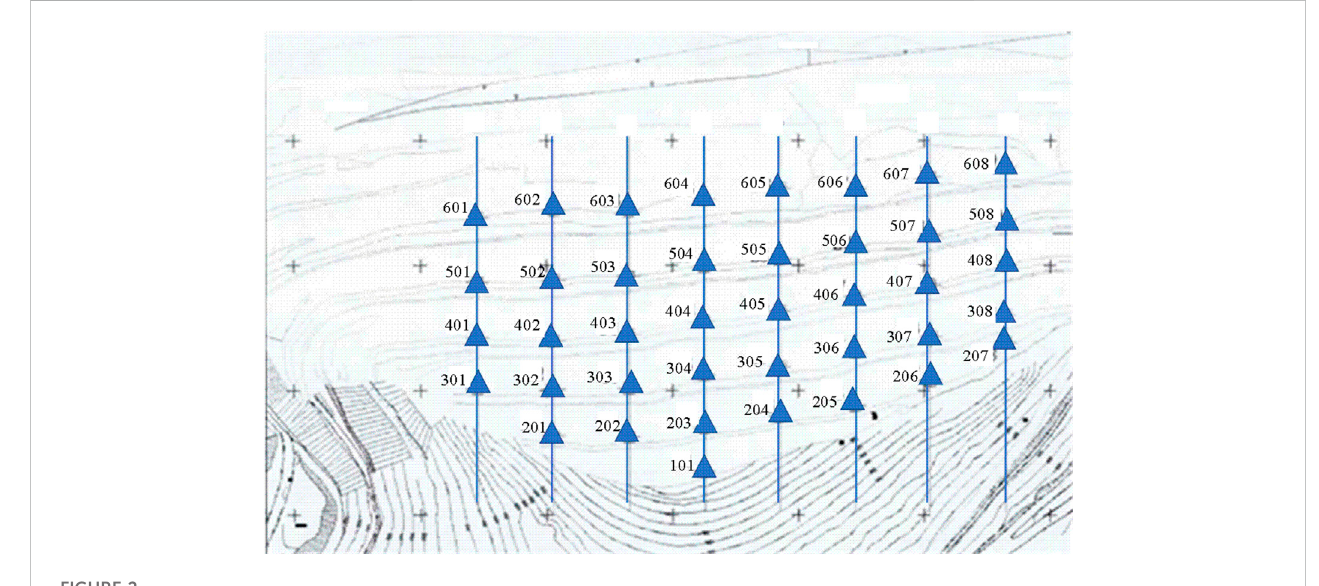
FIGURE 2 Monitoring points of Jianshan mine